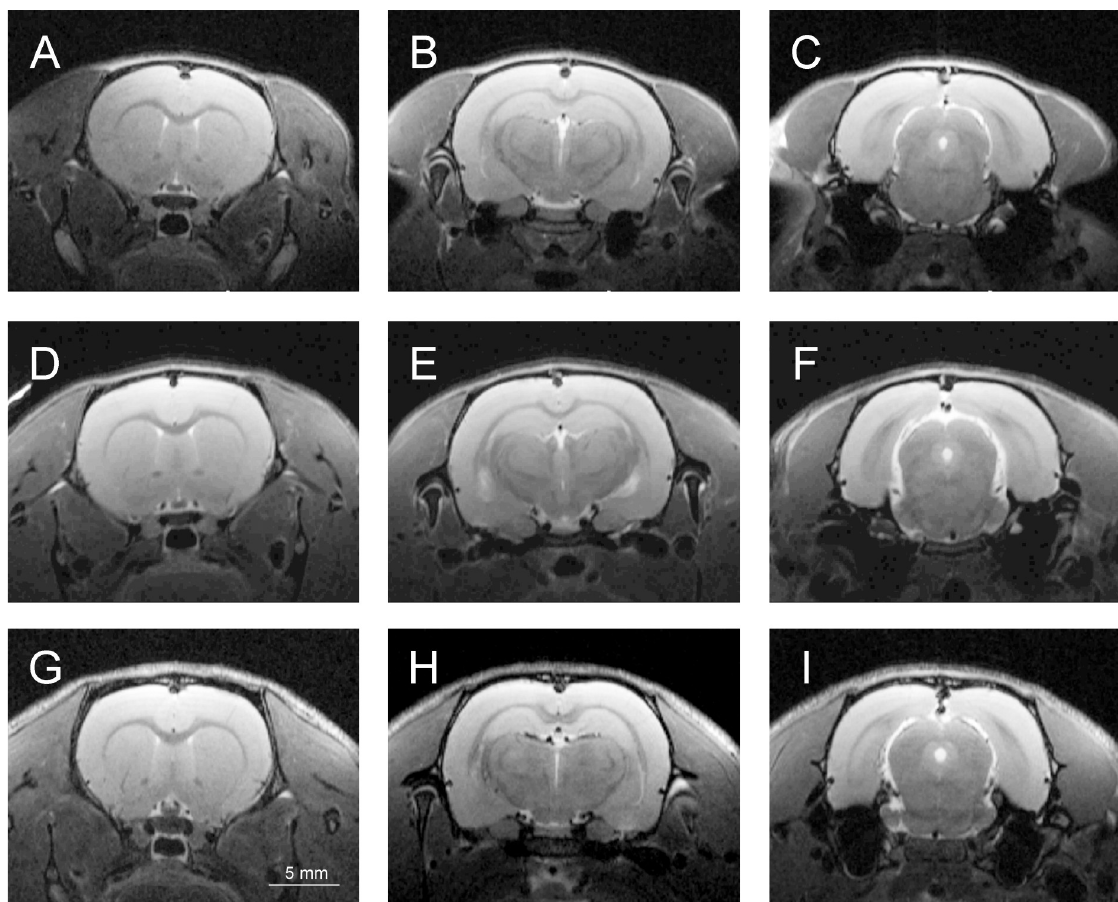
Fig 2. Representative coronal T2-weighted MR images of WWCPS (A-C), BN (D-F) and Wistar rat (G-I).